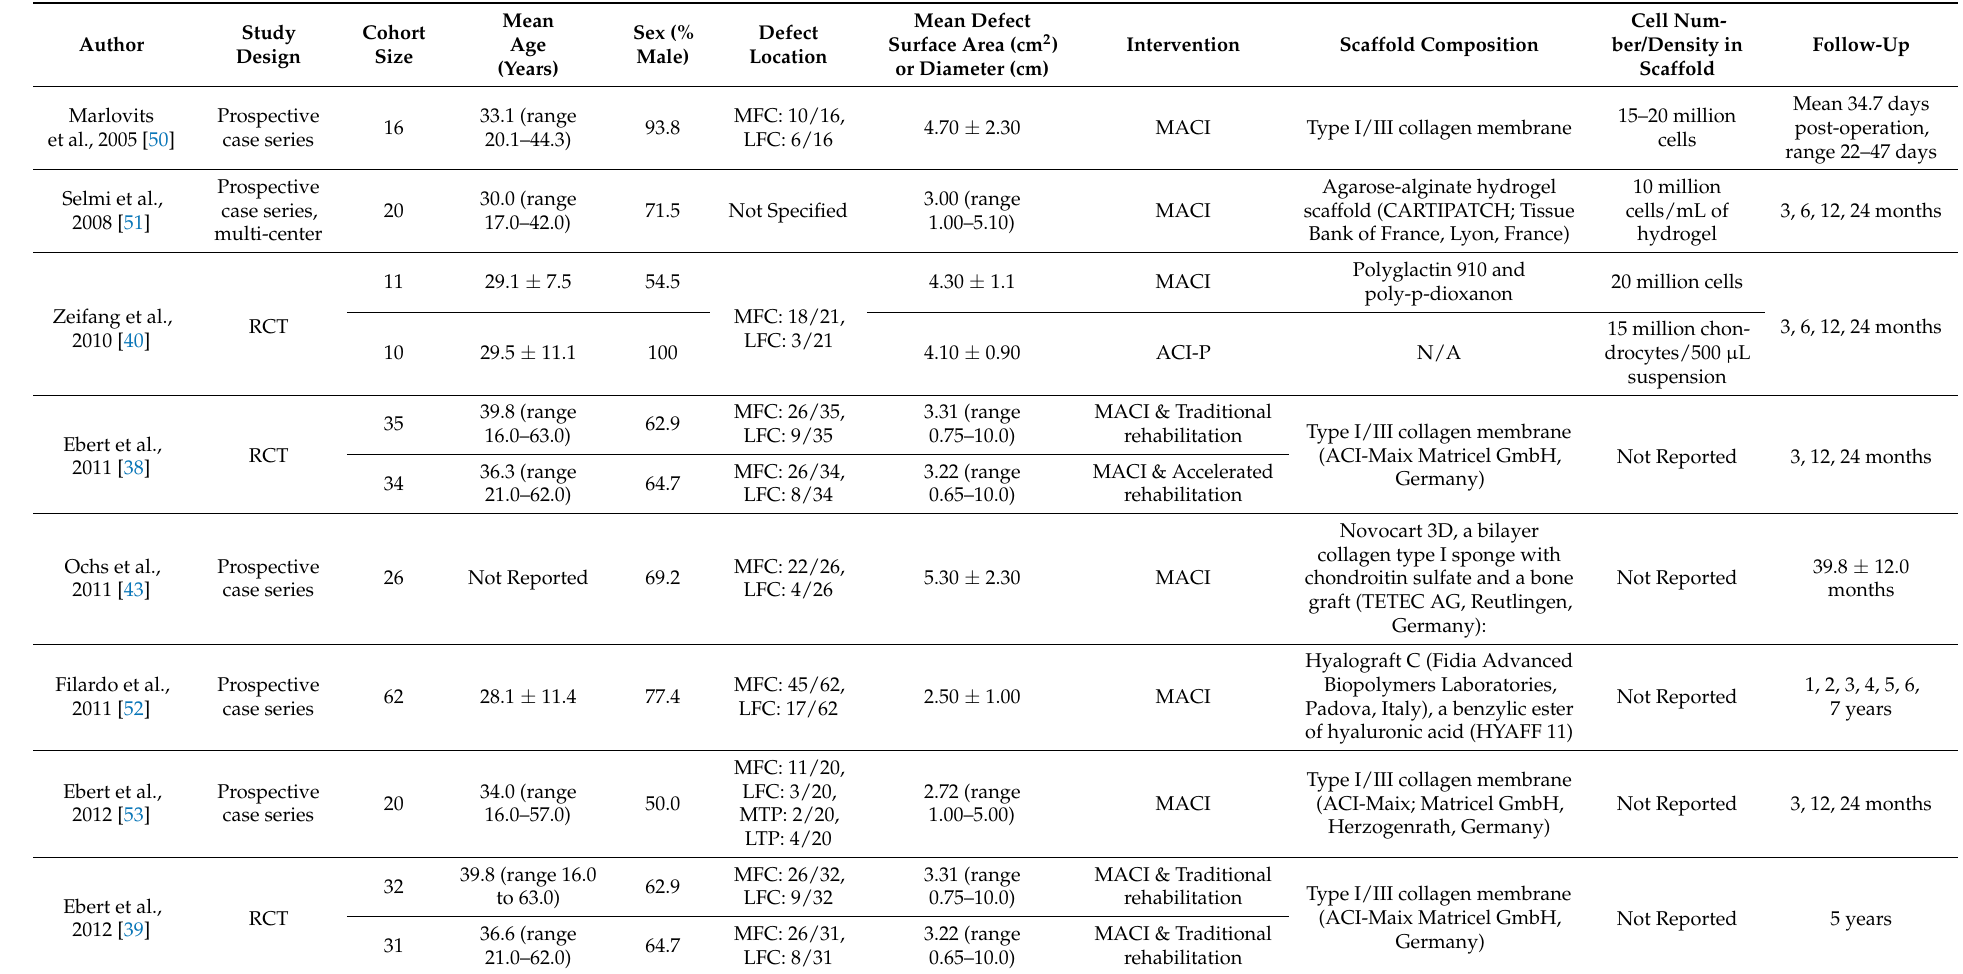
Table 2. Study design and intervention